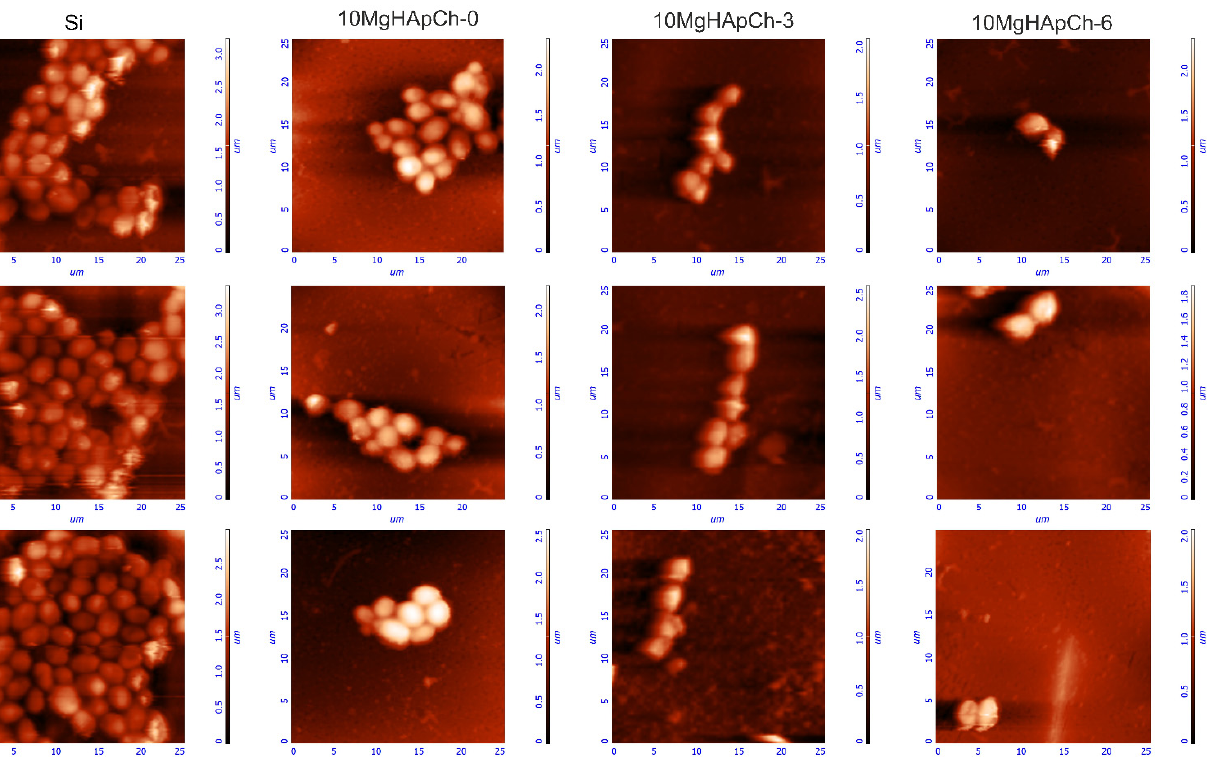
Figure 15. 3D representation of AFM surface topography of Candida albicans ATCC 10231 cell devel- opment on Si discs, 10 MgHApCh-0, 10 MgHAp-Ch-3, and 10 MgHAp-Ch-6 composite layers after 24 h, 48 h, and 72 h of incubation collected on an area of 25 × 25 µm 2 . Moreover, we reported that the antifungal properties of the samples were increased by irradiation. The SEM and AFM investigations revealed a good homogeneity of the sur- face of the non-irradiated and irradiated 10 MgHApCh layers. Additional studies regarding the adherence and development of the C. albicans fun- gal cells on the surface of the 10 MgHApCh composite layers were performed with the